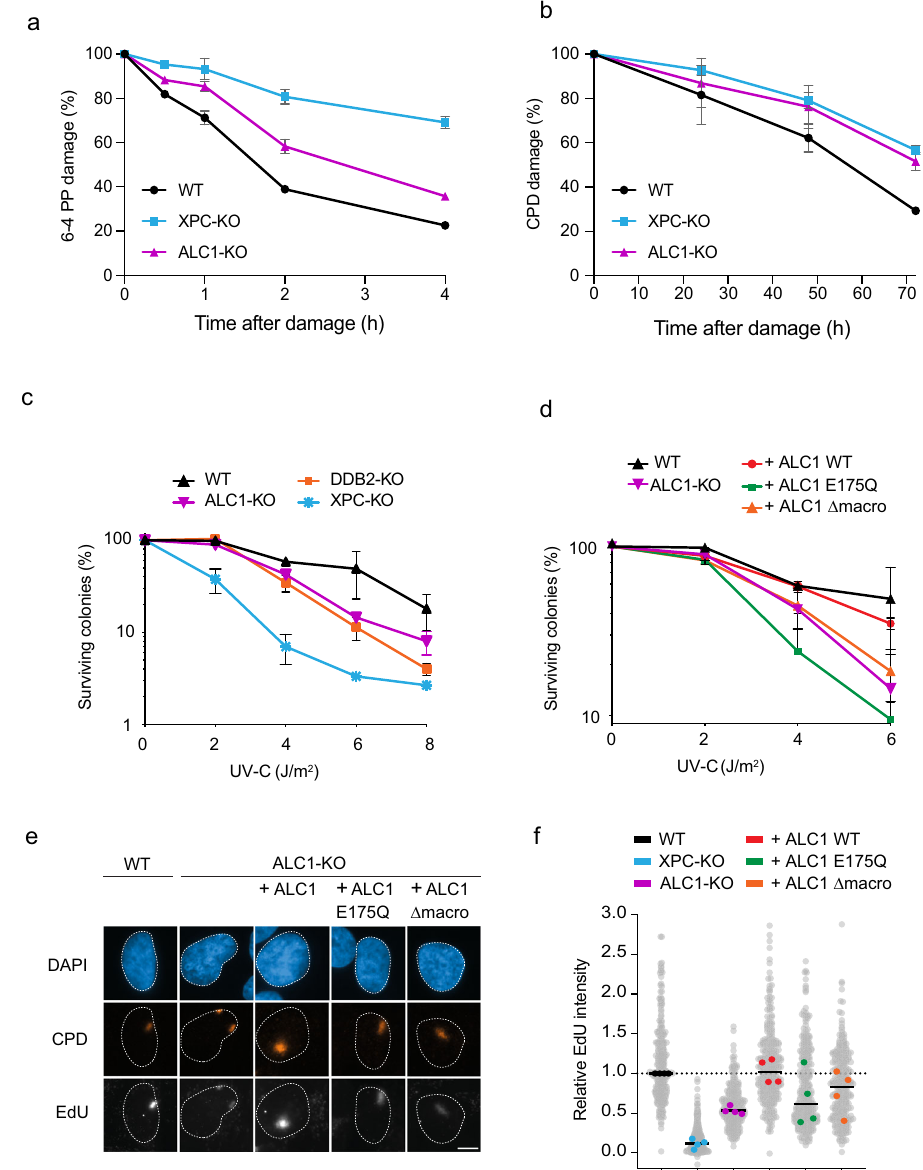
Fig. 8 ALC1 ’ s ATPase activity stimulates XPC-dependent DNA repair. a Quanti fi cation of 6-4PP levels based on slotblot in U2OS (FRT) WT, XPC-KO, and ALC1-KO cells at different time points after UV-C damage (20 J/m 2 ). The data is depicted as mean + S.E.M. of four independent experiments. Representative dot blots are shown in Fig. S5a. b Quanti fi cation of CPD levels based on slotblot in U2OS (FRT) WT, XPC-KO, and ALC1-KO cells at different time points after UV-C damage (20 J/m 2 ). The data is depicted as mean + S.E.M. of four independent experiments where each experiment is based on two technical replicates. Representative dot blots are shown in Fig. S5a. c , d Clonogenic survival assays of c U2OS (FRT) WT, ALC1-KO, DDB2- KO, and XPC-KO cells as well as d U2OS (FRT) WT, ALC1-KO, ALC1-KO + GFP-ALC1, ALC1-KO + GFP-ALC1 E175Q, ALC1-KO + GFP-ALC1 Δ macrodomain cells upon UV-C irradiation. The data are depicted as mean + S.E.M. from three independent experiments. e Representative images and f quanti fi cation of unscheduled DNA synthesis experiments in U2OS (FRT) WT, XPC-KO, ALC1-KO, ALC1-KO + GFP-ALC1, ALC1-KO + GFP-ALC1 E175Q, ALC1-KO + GFP-ALC1 Δ macrodomain cells upon UV-C irradiation. >39 cells were analyzed in four independent experiments. All cells are depicted as individual data points (gray). The median of each biological replicate is depicted as a colored point, whereas the bar represents the median of all data points. The scale bar in e is 5 µ though we could not detect increased PARylation of XPC beyond enzymatic activity of PARP1. Although several studies identi fi ed its basal steady-state PARylation in pull-down experiments. We XPC as a target of PARylation in vitro and upon exogenous DNA envision that the robust UV-induced PARylation of PARP1 may damage treatment of cultured cells with H 2 O 2 48 – 50 , our analysis shows that XPC is not PARylated in response to UV-C irradia- indirectly recruit XPC to the immobilized PAR-binding module. tion. By contrast, PARP1 and ALC1 become extensively deco- Alternatively, XPC may undergo a conformational change at rated with PAR in UV-irradiated cells. Intriguingly, after damaged sites, resulting in the exposure of its steady-state dissociation from UV lesions, XPC was captured by an immo- PARylated residues, leading to its capture at the immobilized bilized PAR-binding module in the same cell nucleus, even PAR-binding module. Deducing the mechanism of PAR